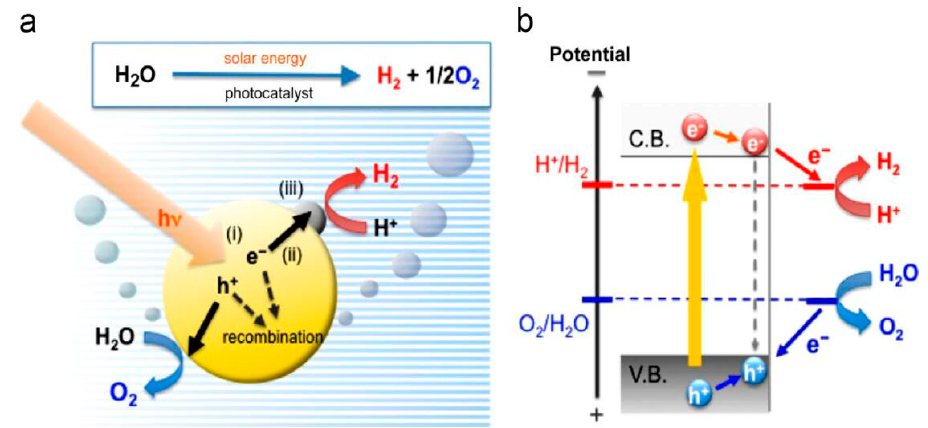
Figure 2. Schematic illustration of hydrogen evolution over photocatalysts. Reproduced with permission from Reference [39]; copyright (2014), Elsevier.